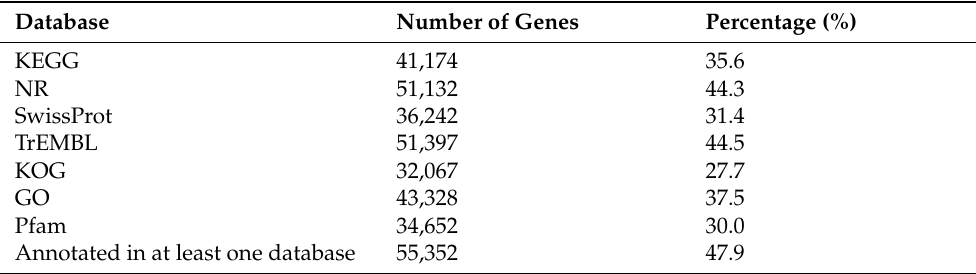
Table 3. Unigene annotation